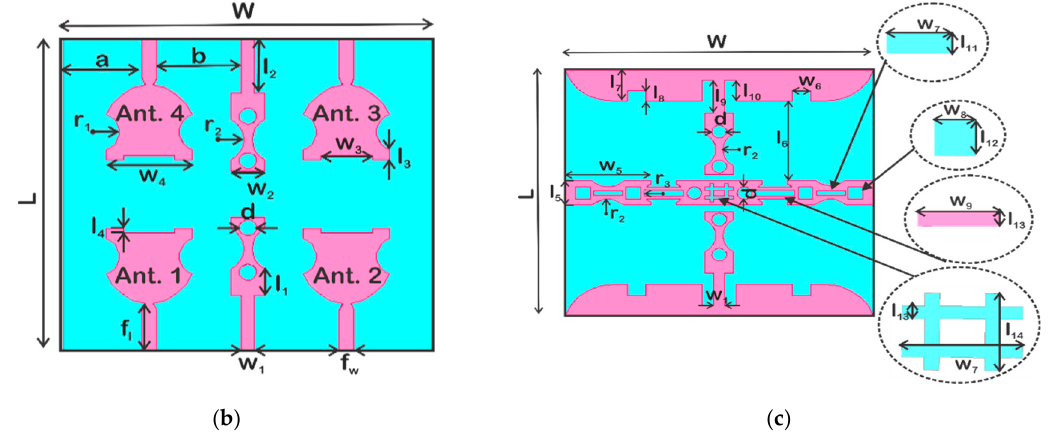
Figure 1. UWB-MIMO antenna design:( a ) single antenna element evolution ( b ) front view of final design; ( c ) rear view of final design; L = 40,W = 43, f l = 6, f w = 1.8, l 1 = 3, w 1 = 1.5,l 2 = 7, w 2 = 4, l 3 = 1.3, w 3 = 6, l 4 = 0.6, w 4 = 10, l 5 = 4, w 5 = 12, l 6 = 13, w 6 = 2.6, l 7 = 5.1, l 8 = 1.7, l 9 = 5.3, l 10 = 3.4, l 11 = 0.8, w 7 = 4, l 12 = 2,w 8 = 2, l 13 = 0.5, w 9 = 5.5, l 14 = 3, d = 2, r 1 = 2.5, r 2 = 3, r3 = 1.5, a = 9.1, b = 9.8 (all dimensions are in mm).